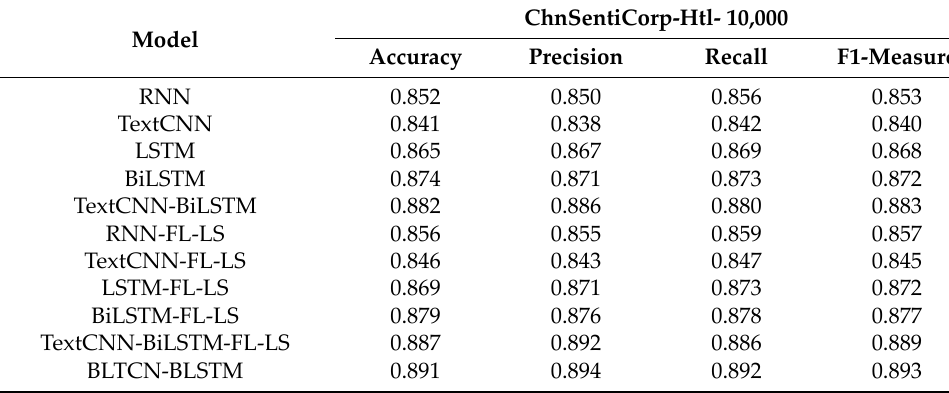
Table 5. Comparison of experimental results of different